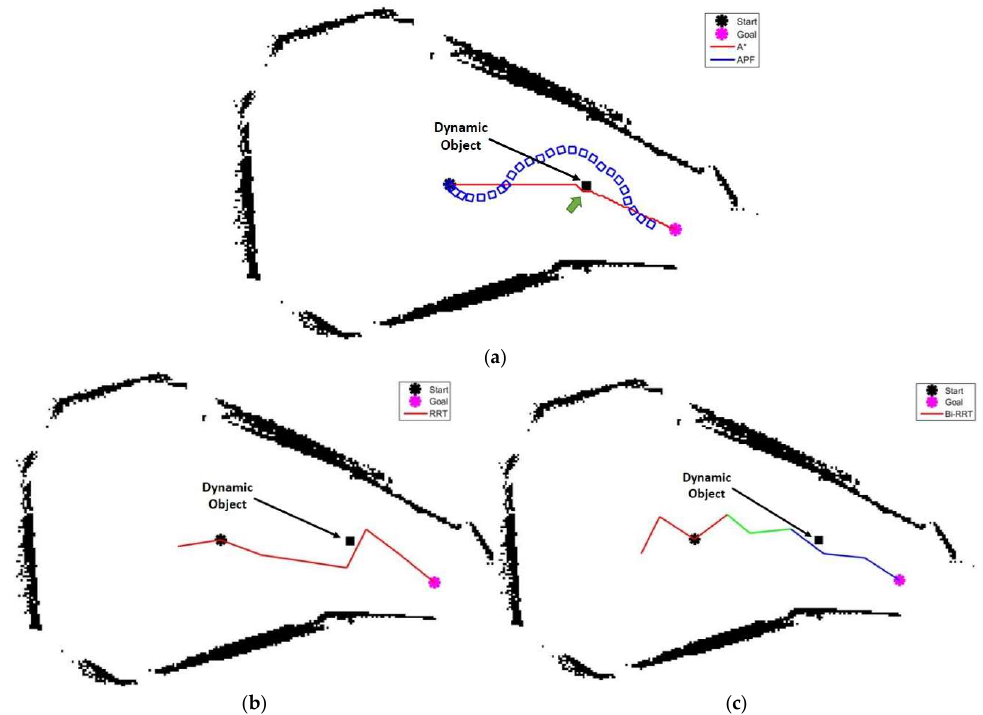
Figure 19. Generated path, for Dataset III, using: ( a ) A* algorithm and APF method; ( b ) RRT algorithm; and ( c ) bidirectional RRT algorithm.